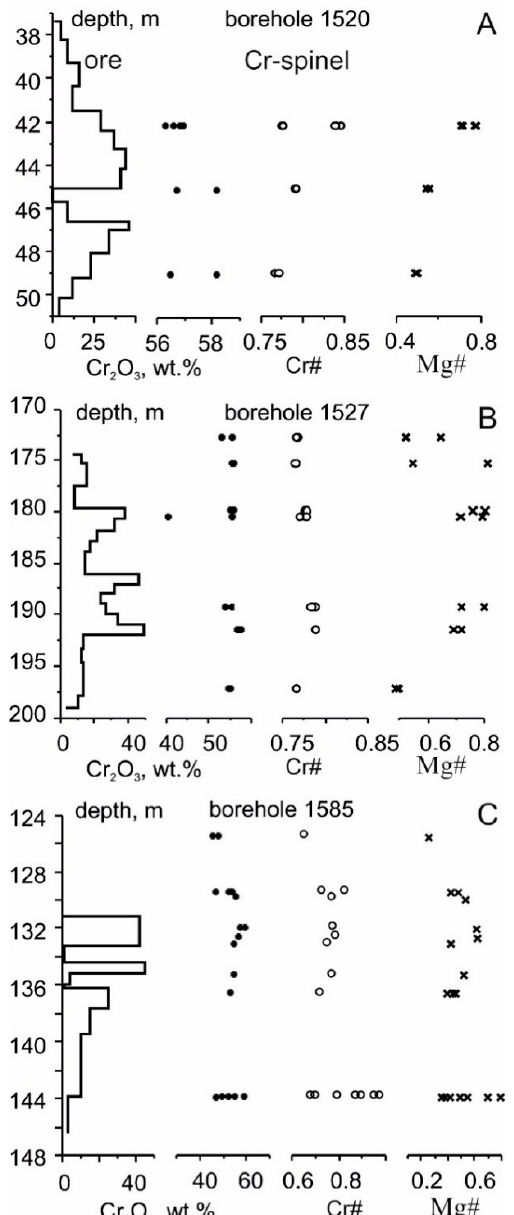
Figure 7. Composition of Cr-spinel phases in the cross-section of ore intervals in boreholes 1520 ( A ), 1527 ( B ), and 1585 ( C ). Indexes Cr# = Cr/Cr + Al 3+ and Mg# = Mg/Mg + Fe 2+ (a.p.f.u.). Designations of boreholes are shown in Figure